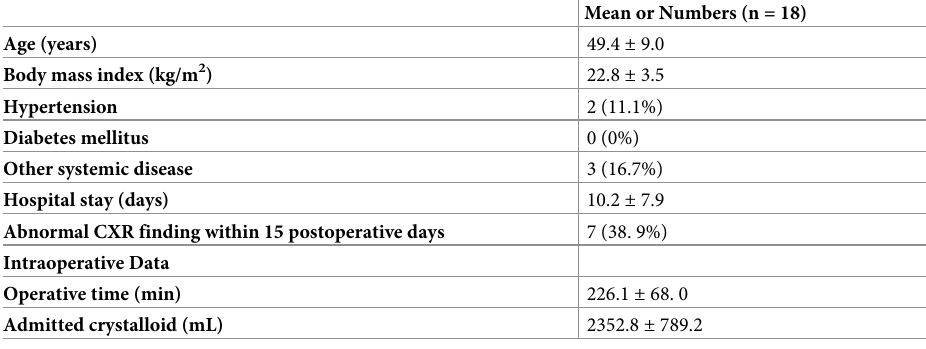
Table 1. Demographic and perioperative characteristics of the study patients.